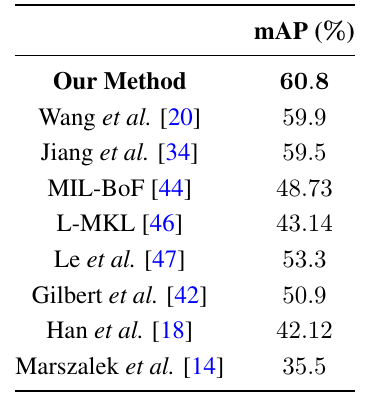
Table 1. Performance comparison of the proposed GPMK with previous methods in action classification literature (Hollywood2 [14]).